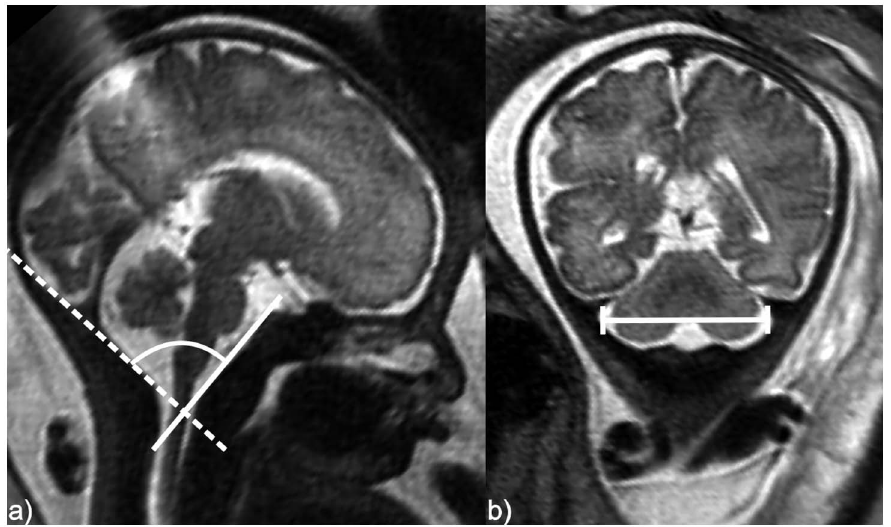
Figure 1. Schematic drawings of the CSA and the TDPF a) Measurement of the CSA. Midsagittal T2-weighted SSFSE MR image of a fetus at 33 GW. Continuous line along the postero-superior surface of the clivus connecting the most cranial part of the clivus with the anterior border of the foramen magnum (basion). Dashed line along the antero-superior surface of the supraocciput cutting the posterior border of the foramen magnum (opisthon). The angle between these two lines is the CSA. b) Measurement of the TDPF. Coronal T2-weighted MR image of a fetus at 33 GW. The distance between the medial surfaces of the lateral bony margins of the posterior fossa at the level of the lateral insertions of the tentorium cerebelli was measured.